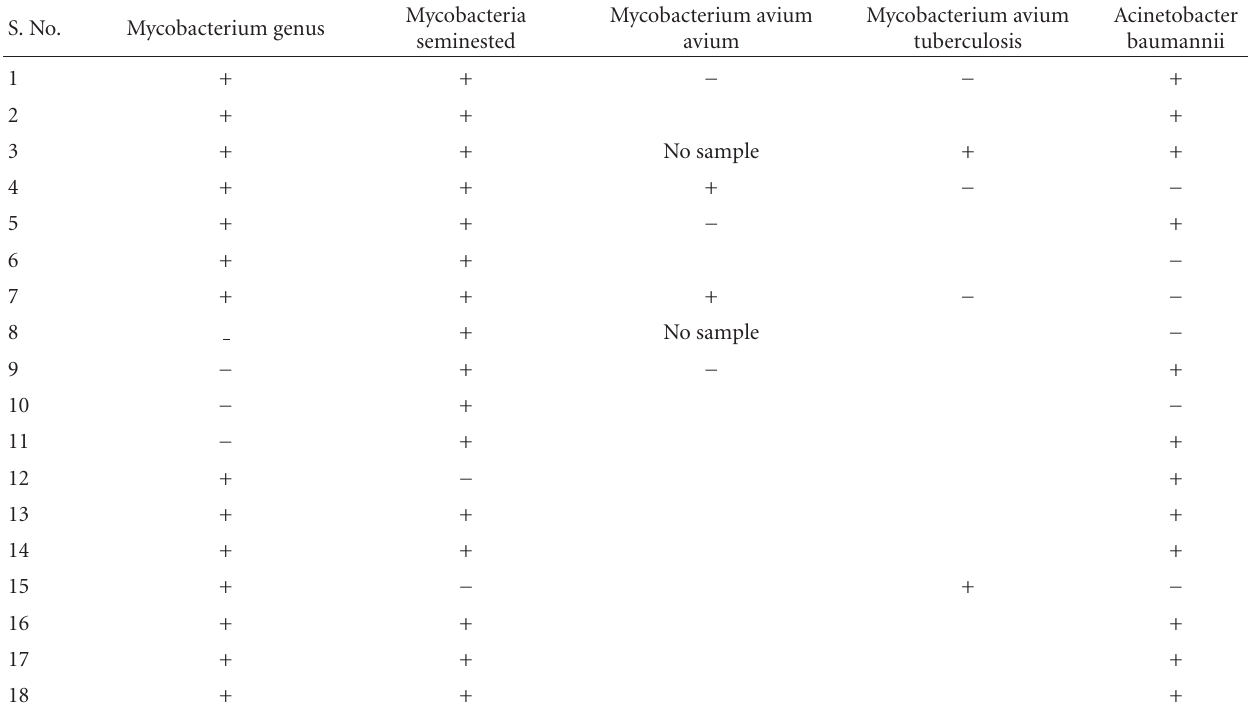
Table 4: Diagnostic results with Polymerase Chain reaction of positive cases in the second test run. S.